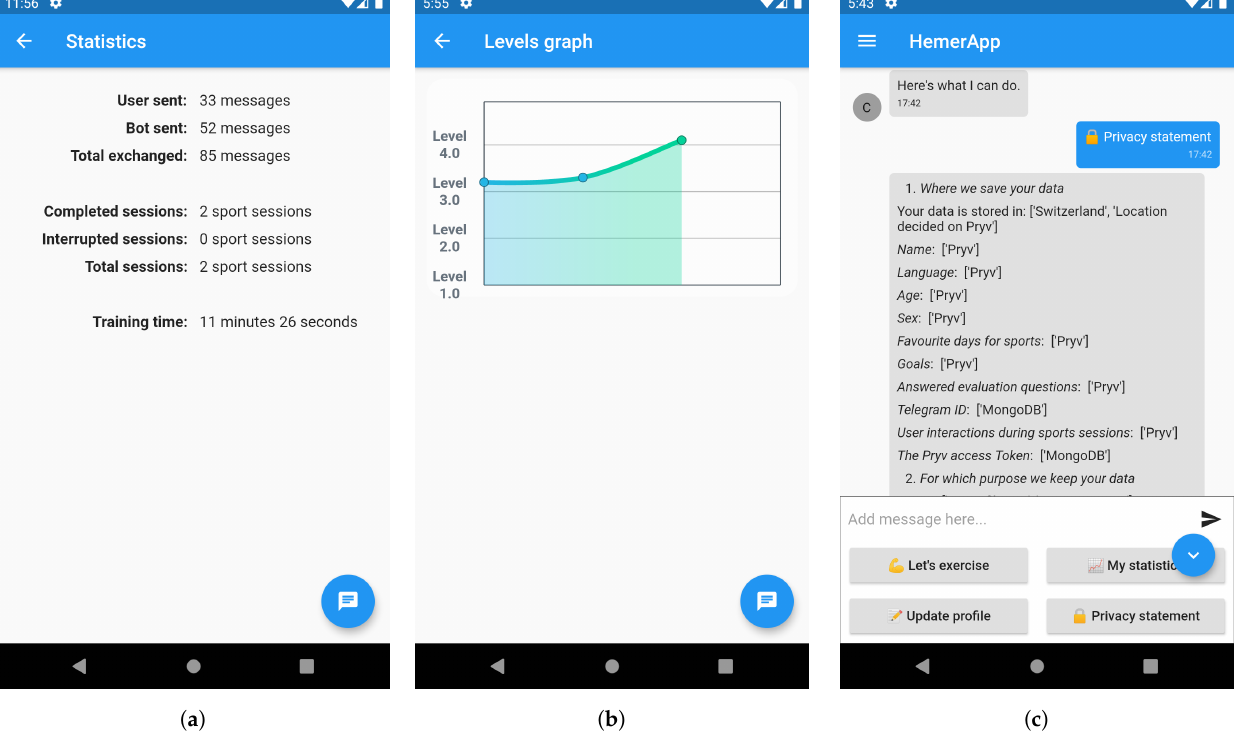
Figure 12. User’s usage statistic, training’s difficulty trend, and data privacy statement. ( a ) Usage statistics. ( b ) User level information. ( c ) Dynamic data privacy